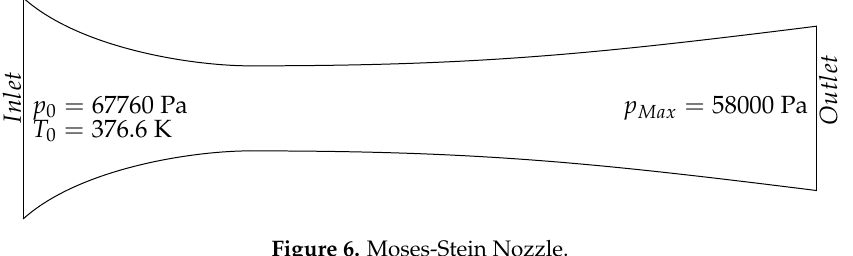
Figure 6. Moses-Stein